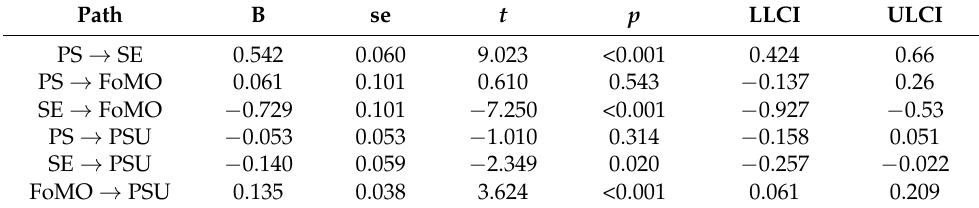
Table 3. Results of path analysis.